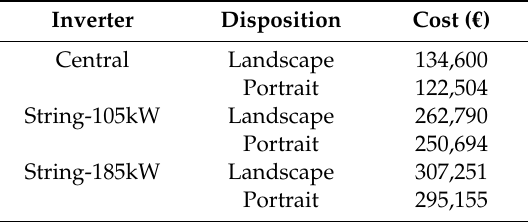
Table A3. Cables’ total cost.